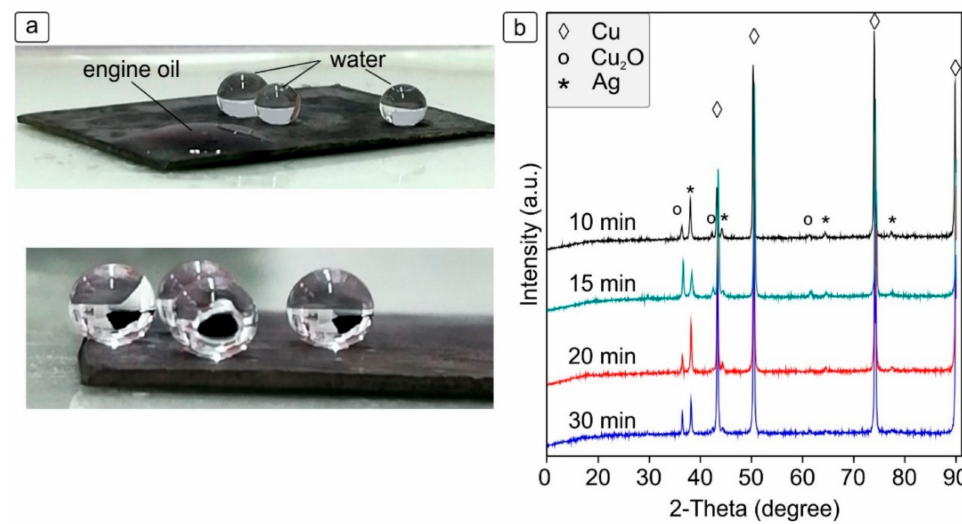
Figure 5. ( a ) Typical images of water droplets of about 6 µ L on the surface of silver-silver-coated copper prepared under optimum conditions. ( b ) X-ray diffraction (XRD) results for